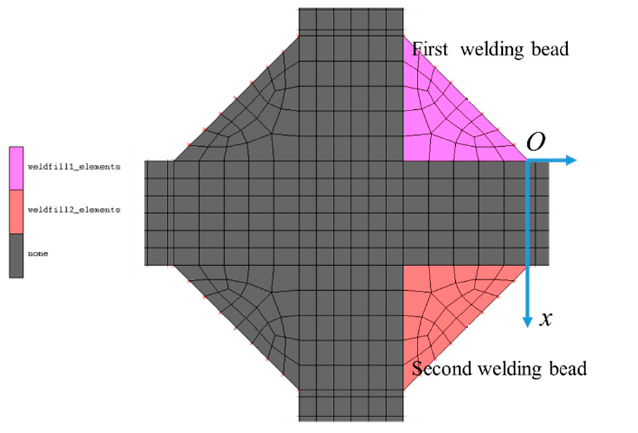
Figure 8. Weld bead and extraction path of transverse residual stress. ( a ) Schematic of bead fill for single pass welding; ( b ) Extraction path of transverse residual stress in crack propagation plane.